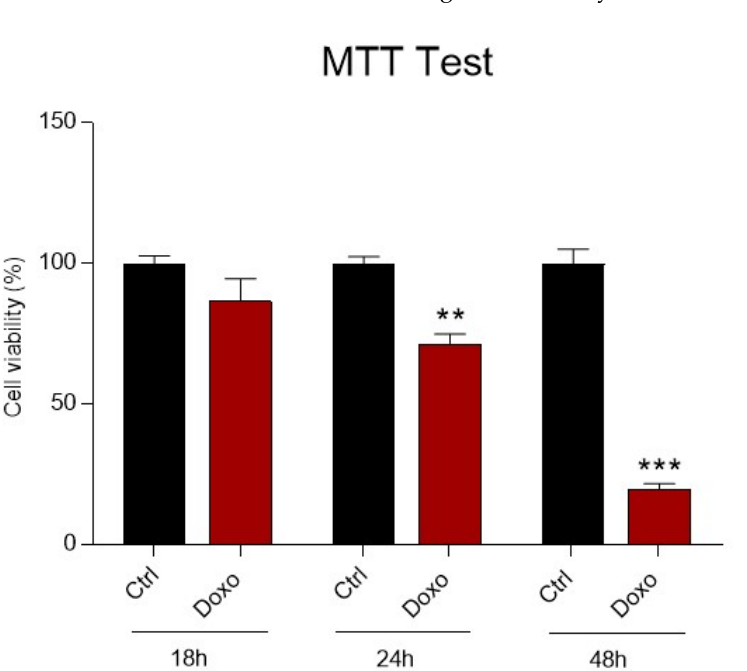
Figure 1. The effect of Doxorubicin treatment on H9c2 cell viability. H9c2 cells were treated with Doxorubicin (Doxo) 1 µ M at three-time points (18 h, 24 h and 48 h). Treatment with Doxo induces a time dependent reduction in cell viability. Data are presented as mean ± SEM. ** p < 0.01 vs. Ctrl (24 h); *** p < 0.001 vs. Ctrl (48 h); Mann Whitney test ( n = 8). Data is from three different independent